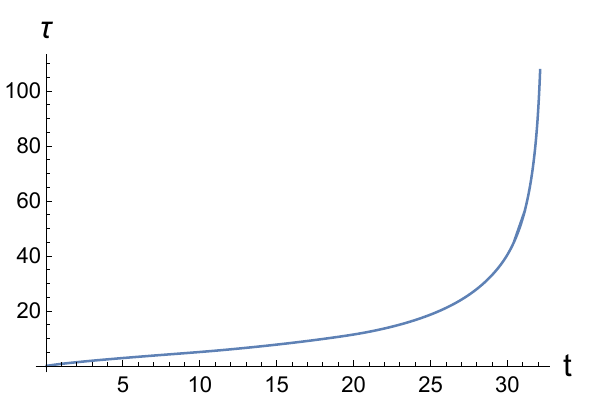
Figure 5 . The relation between t and τ . The parameters are chosen as (4.6) and V min = 0 .